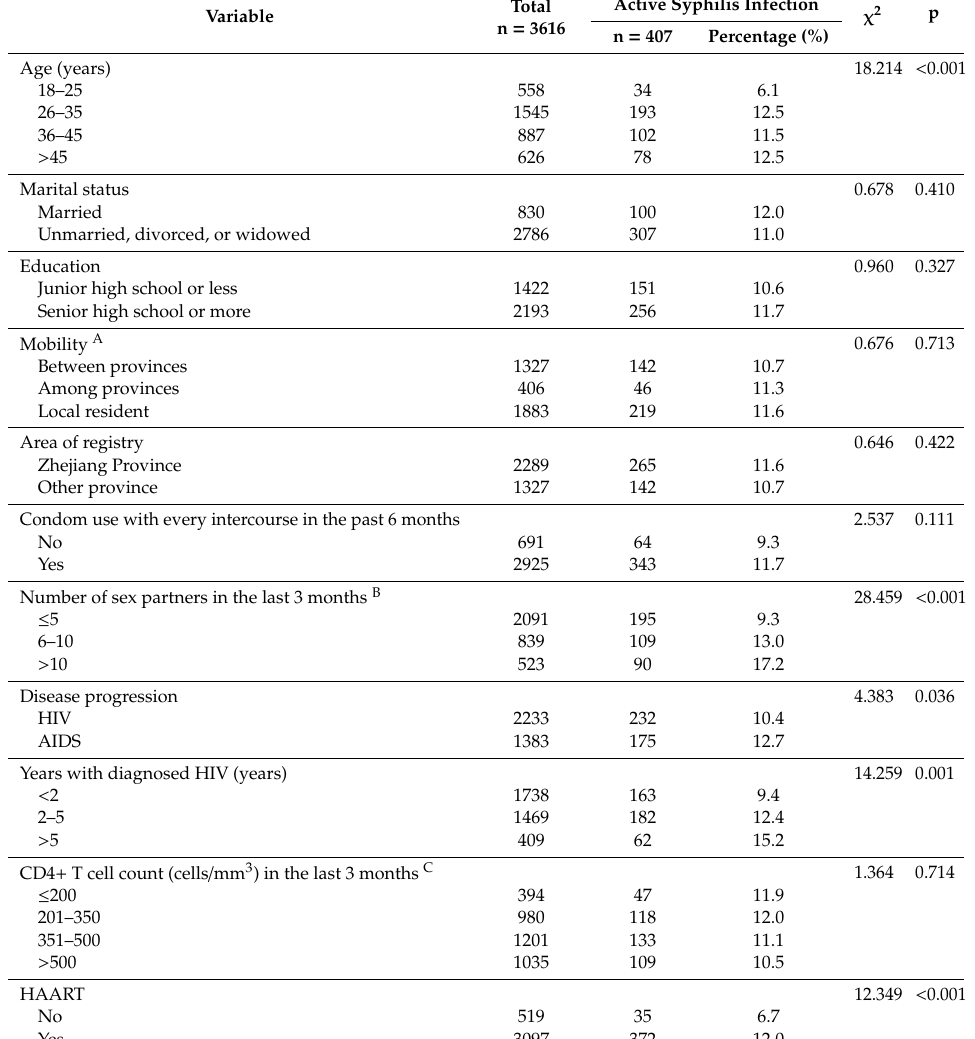
Table 1. Sociodemographic characteristics, risky behavior, disease progression, years with diagnosed HIV, CD4 + T cell count, HAART, and relationship with active syphilis infection among MSM living with